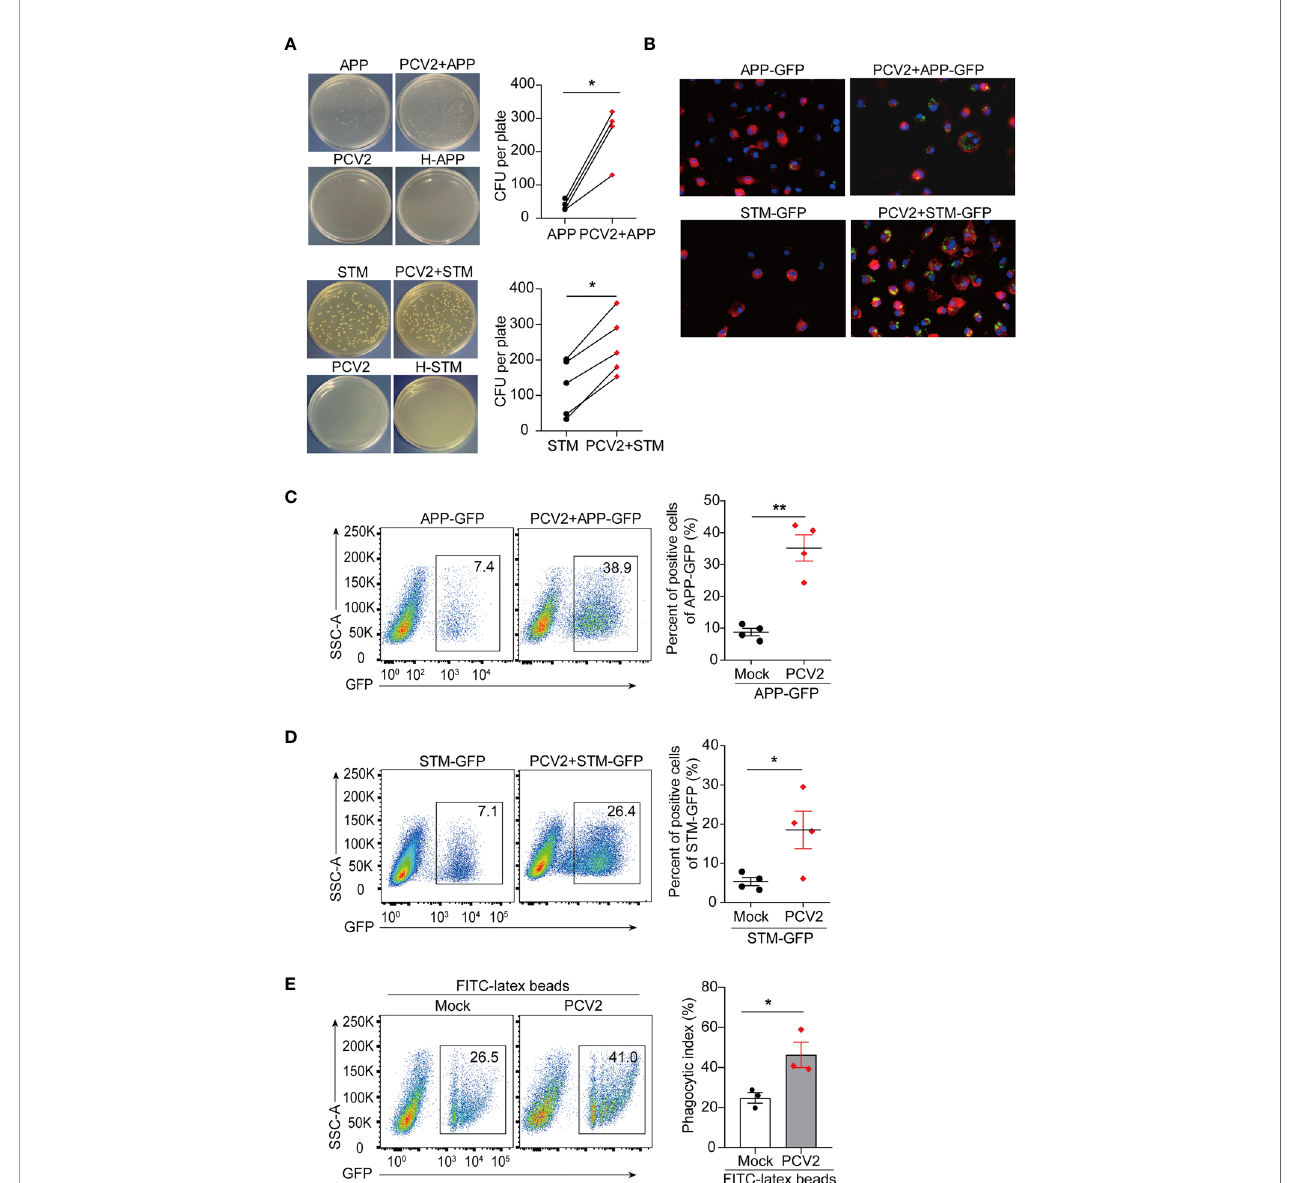
FIGURE 5 | PCV2 priming facilitates bacterial infection in macrophages. (A) CFU of APP or STM in PCV2-infected BMDMs or control cells. Macrophages were infected with APP or STM for 3 h at a dose of MOI=10 (the same dose below). H-APP/STM: bacteria were heated at 70°C for 30 min to kill all bacteria as a negative control. Cumulative data were pooled from four or fi ve independent experiments (right, mean + s.d.). (B) Fluorescence microscope of GFP positive BMDMs infected with APP-GFP or STM-GFP alone for 3 h or infected with PCV2 for 12 h followed by APP-GFP or STM-GFP for another 3 h. Cell membranes were labelled with a red fl uorescence probe Dil (red) and nucleus were stained with DAPI (blue). (C, D) FACS analysis of GFP positive cells in BMDMs infected with APP-GFP (C) or STM-GFP (D) alone or infected with PCV2 for 12 h followed by APP-GFP or STM-GFP for another 3 h. Cumulative data are from four independent experiments (right, mean + s.d.). (E) FACS analysis of green fl uorescence positive cells in BMDMs left untreated or infected with PCV2 for 12 h followed by inoculation with FITC- labeled latex beads for 30 min. Data are pooled from three independent experiments (mean + s.d.). * P < 0.05; ** P < 0.01 (Student ’ s paired t